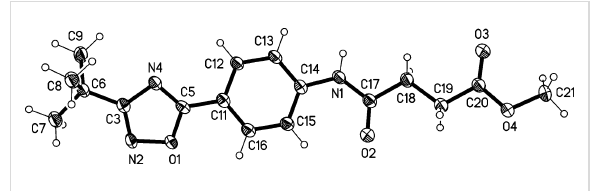
Figure 8: Molecular structure of 4-(4-(3- tert -butyl-1,2,4-oxadiazol-5- yl)phenylamino)-4 oxobutanoate ( 5 ). Atoms are drawn as 50% thermal ellipsoids.